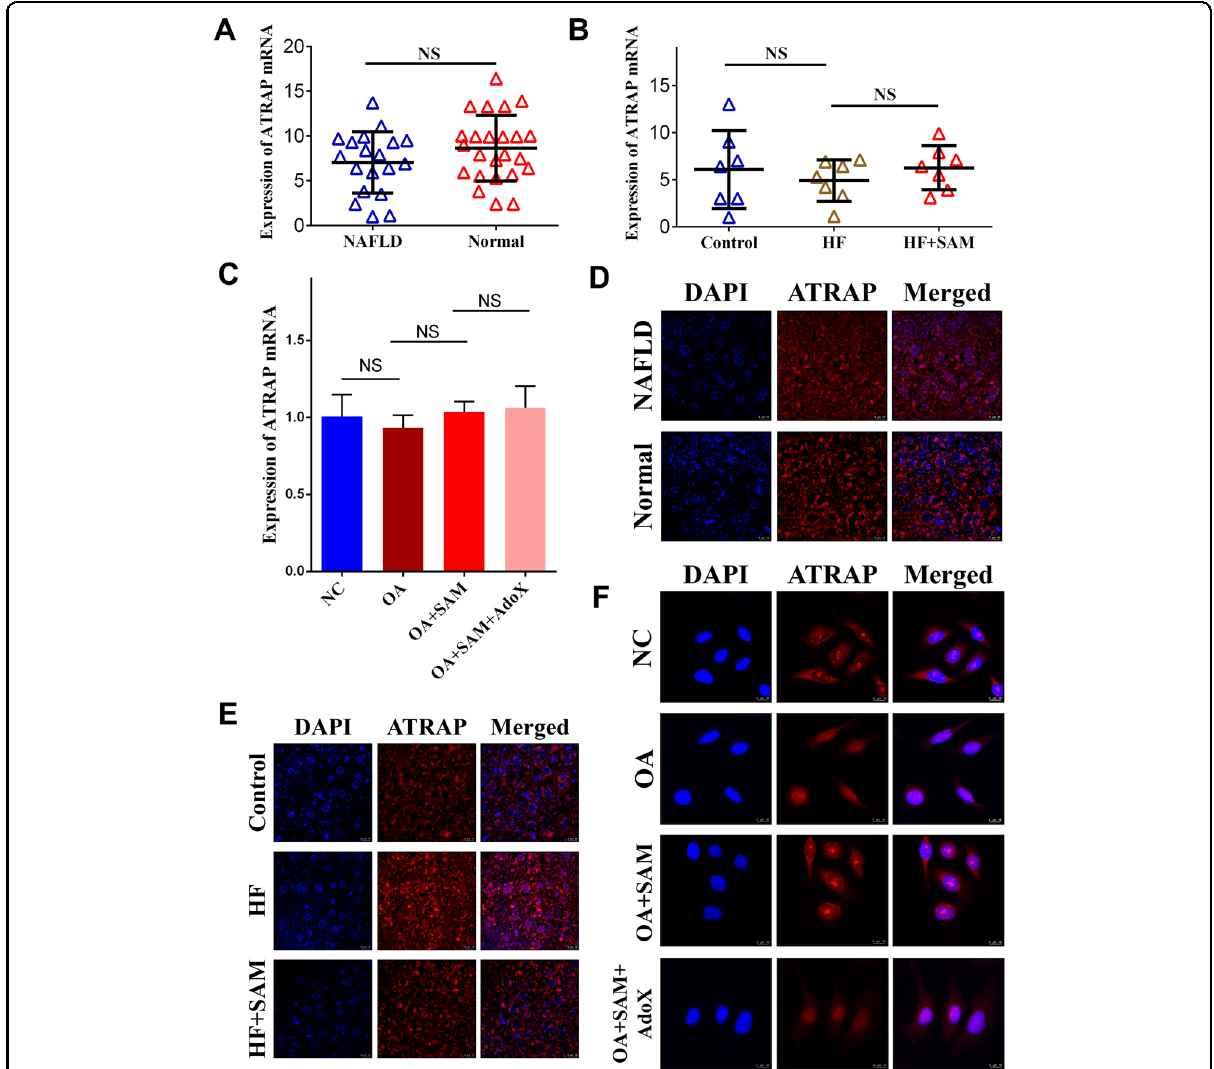
Fig. 3 ATRAP mRNA translocation in NAFLD. A ATRAP mRNA levels in NAFLD and normal liver tissues, as determined by q-PCR. B ATRAP mRNA levels in the liver tissues of rats in the control, HF, and HF plus SAM groups. C The expression of ATRAP mRNA in L02 cells after OA, OA plus SAM, and OA plus SAM plus AdoX treatment. The error bars are the SDs ( n = 3). D Fluorescence in situ hybridization images showing ATRAP mRNA in NAFLD and normal liver tissues (bar = 10 μ m). E RNA FISH detection of ATRAP mRNA in the livers of rats from the control, HF, and HF plus SAM groups (bar = 10 μ m). F FISH images showing the subcellular localization of ATRAP mRNA in L02 cells treated with OA, OA plus SAM, and OA plus SAM plus AdoX (bar = 10 μ m). NS not signi fi